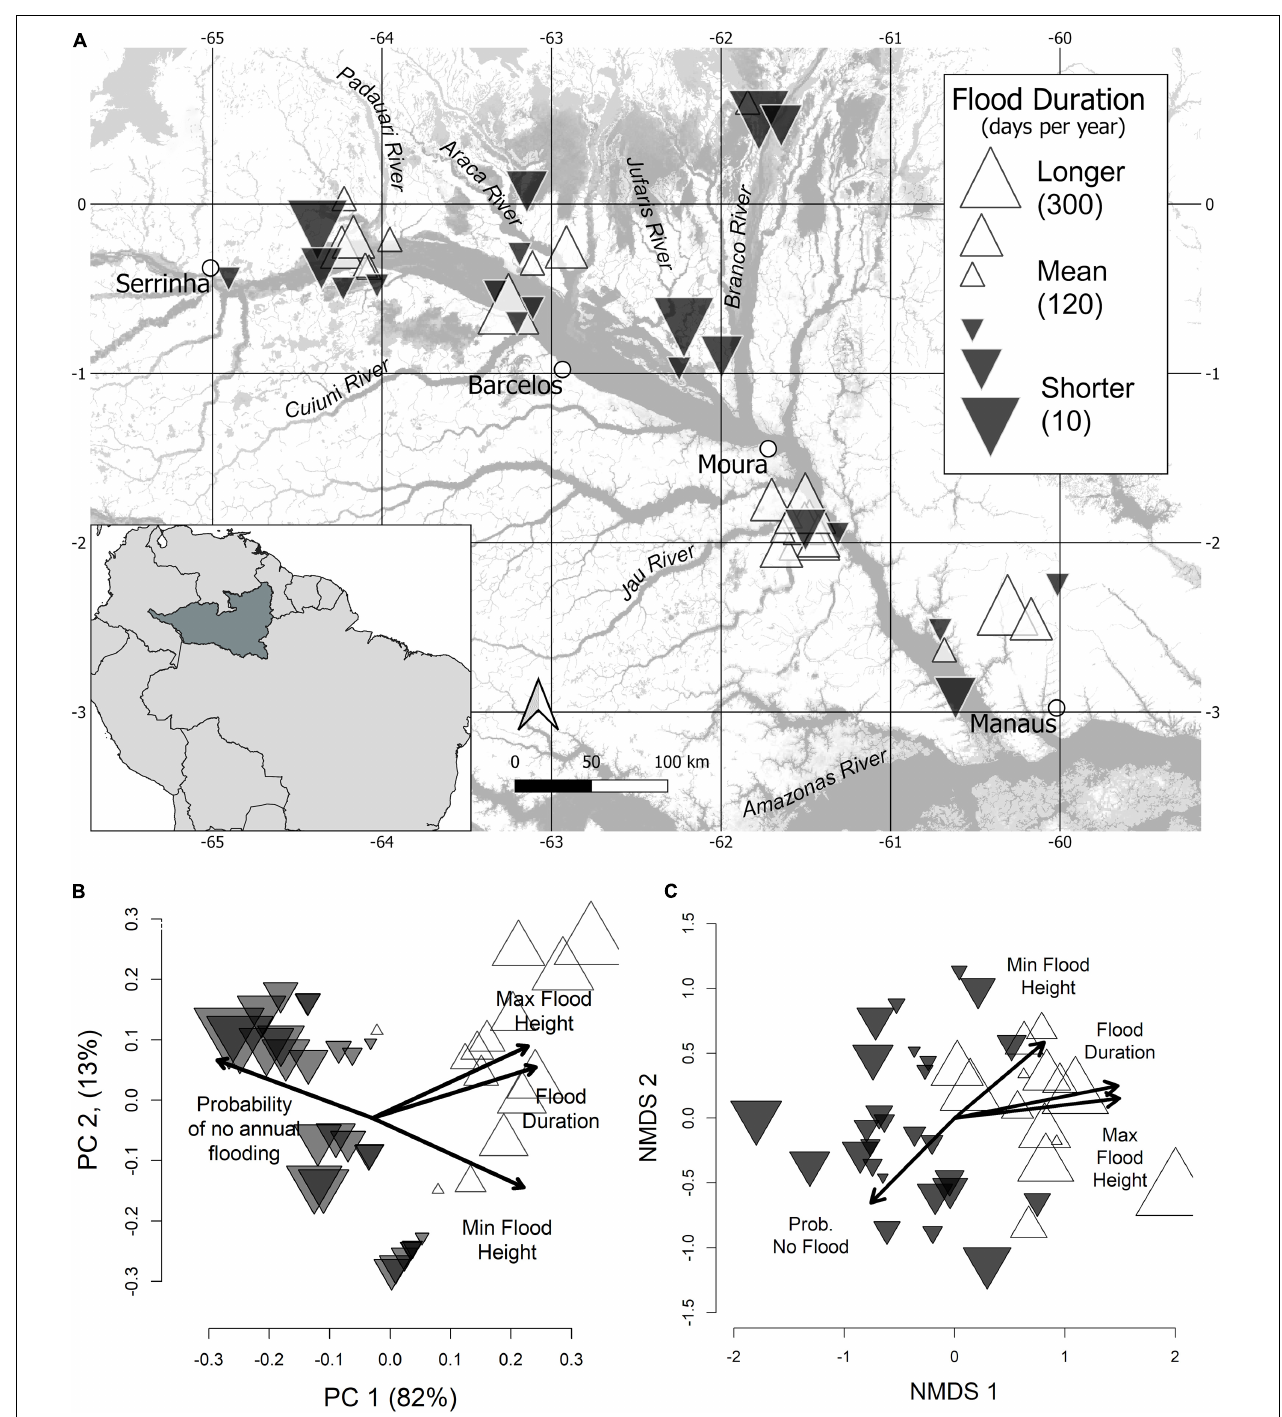
FIGURE 1 | Geographic (A) , hydrologic (B) , and compositional (C) pattern of floodplain forest inventories. In all panels, inventories are represented by triangles, where size and color reflect direction and magnitude from the mean flood duration across all sites. Symbol size is proportional to the absolute difference from mean conditions, where black-filled, and white-filled, triangles are below and above the mean, respectively. (A) Geographic positions of inventoried sites. A small amount of random scatter was added to reduce overlapping symbols. Open circles indicate gauge locations used to calibrate historical flooding conditions at each inventory. The base layer showing flooded areas has been adapted from Hess et al. (2003), based on dual season Global Rain Forest Mapping Project (GRFM) Amazon mosaics. (B) Principal Components Analysis showing covariation in 4 hydrological variables, flood duration, maximum flood height, minimum flood height, and annual flooding probability. (C) Non-metric multidimensional scaling solutions (in two dimensions) of inventory compositional data based on Sørensen’s distance metric (stress = 0.19). Fitted vectors of significant ( p < 0.001) hydrologic variables have been mapped on, where their length is scaled to their correlation coefficient ( R 2 ).